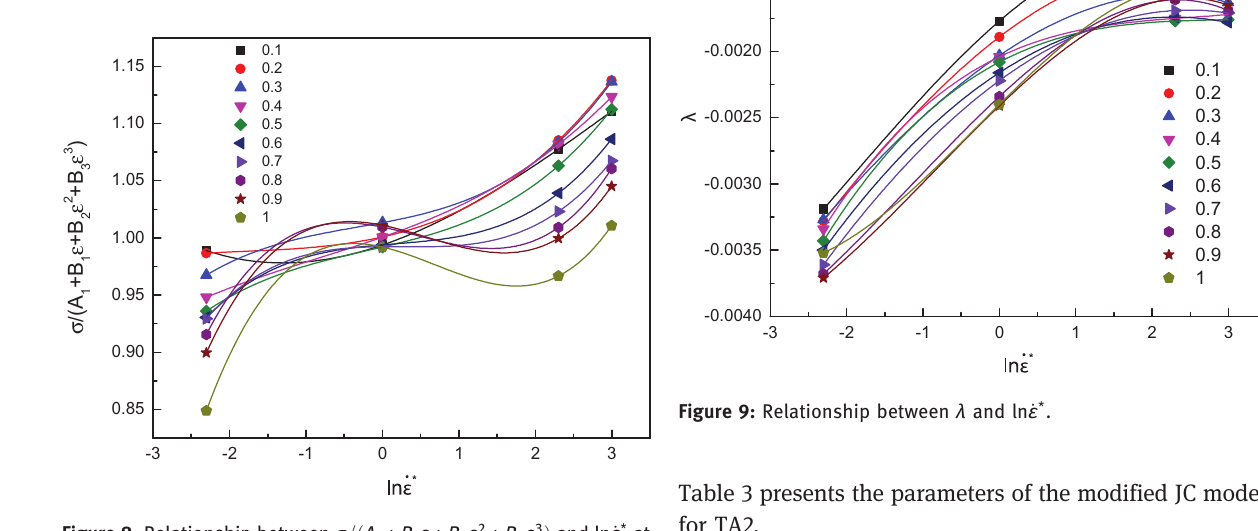
Figure 8: Relationship between σ = A 1 + B 1 ε + B 2 ε 2 + B 3 ε 3 ð Þ and ln _ ε * at the temperature of 933 K.